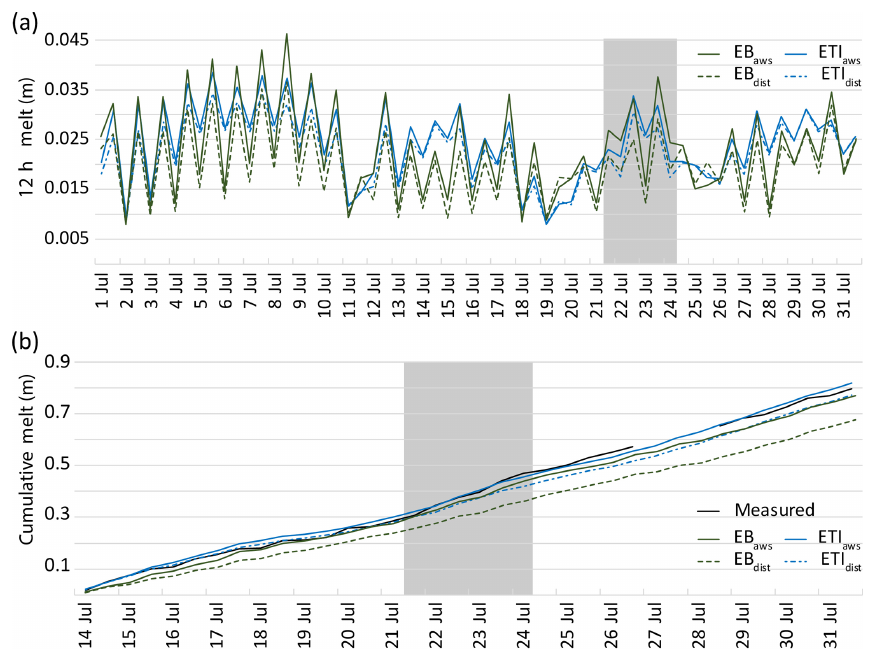
Figure 4. (a) Modelled 12h melt values at the AWS site on 1–31 July 2016. (b) Cumulative measured and modelled melt at the AWS on 14–31 July 2016. SR50 measurements were only available for the second half of July, and a gap exists in the record due to melt out of the pole holding the SR50. Melt was extrapolated during this time for better visual comparison, and extrapolation was based on average melt rates for the day prior to and following the gap. The dates of the UAV study are shown in